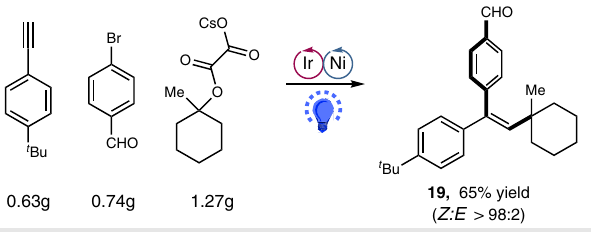
Fig. 4 Reaction on large scale. Reaction condition: Ir- 1 (3mol%), NiCl 2 (cid:129) glyme (20mol%), dtbbpy (20mol%), alkyne (4mmol), oxalate (1.5 equiv.), bromide (2.0 equiv.), DMSO [0.05M], 90W blue LED, 36°C, 18h. Isolated yield. The ratio of the two isomers were determined by 1 H NMR analysis of the crude reaction mixture. dtbbpy = 4,4 ′ -di- tert -butyl-2,2